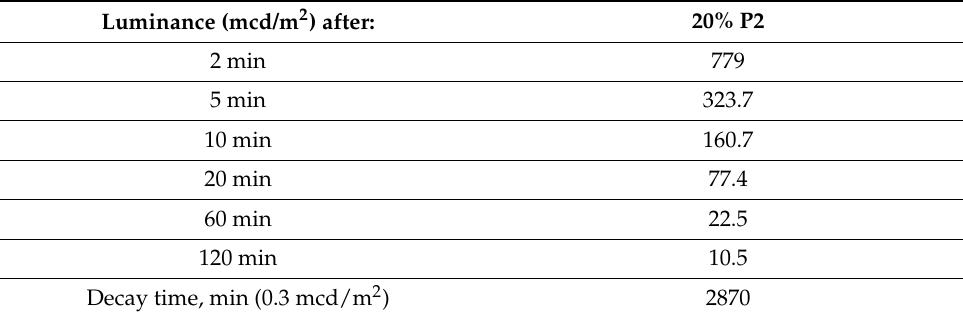
Decay time, min (0.3 mcd/m 2 )